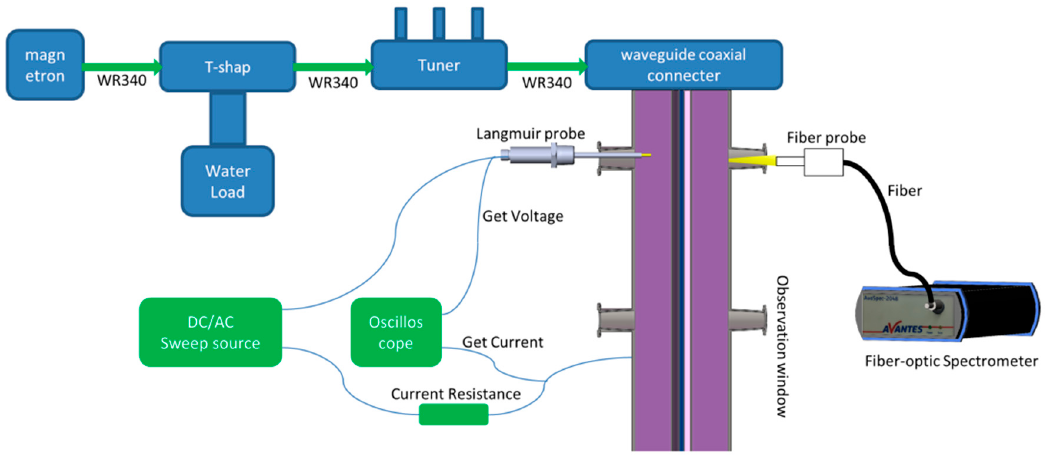
Figure 1. Schematic diagram of the coaxial microwave-driven plasma with Langmuir probe and emission spectroscopy.